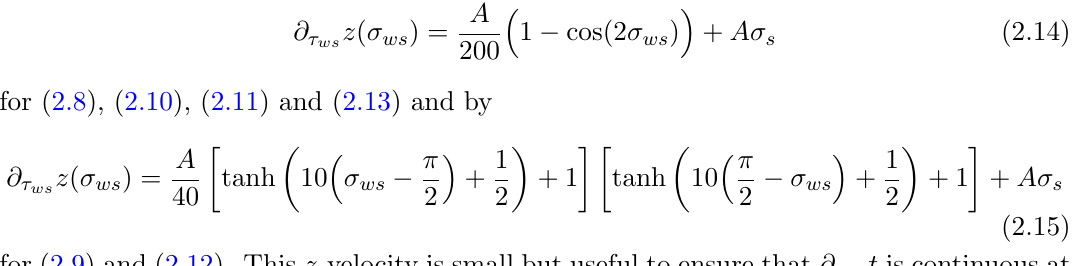
JHEP02(2018)015